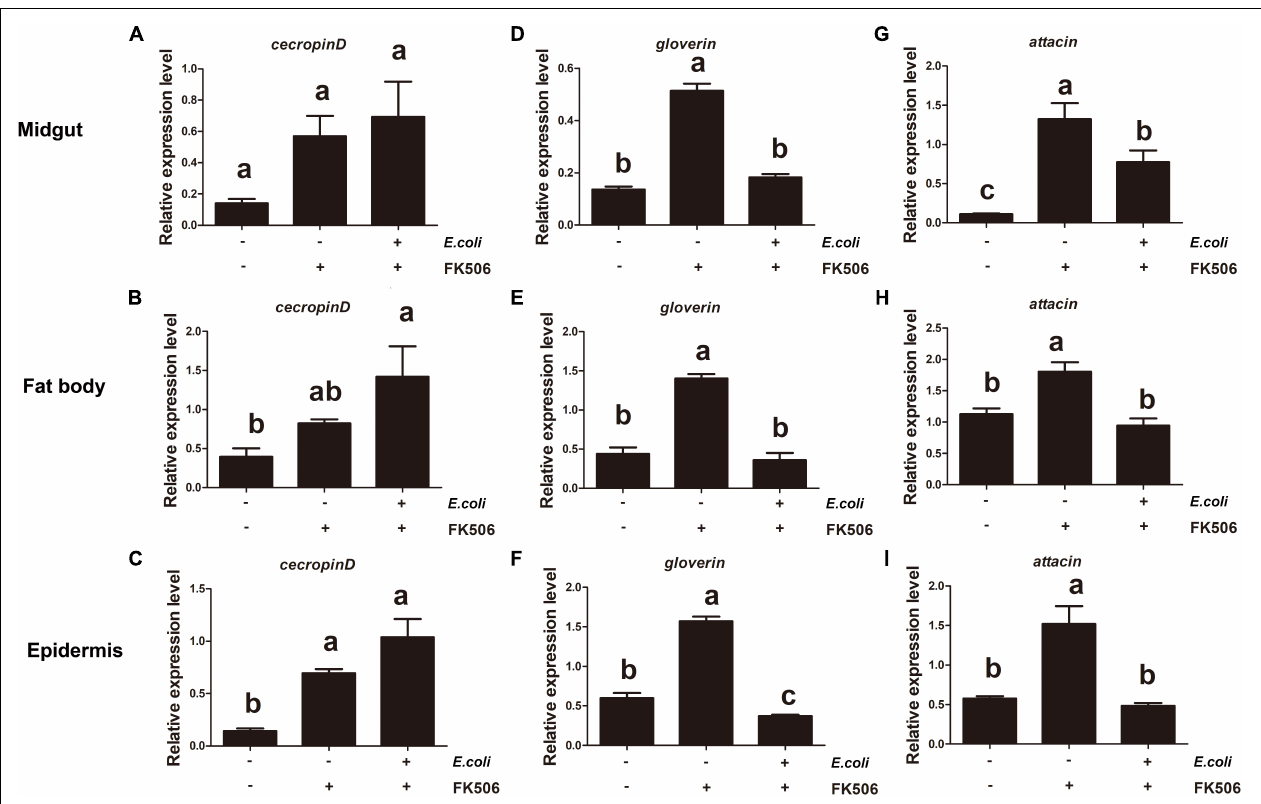
FIGURE 6 | Expression levels of endogenous antimicrobial peptides (cecropin D, attacin, and gloverin) in the midgut, fat body, and epidermis in response to Escherichia coli infection and E. coli + FK506 in fourth instar H. armigera after 3 h treatment. (A–C) Represent the relative expression levels of cecropin D in the migut, fat body, and epidermis, respectively. (D–F) Represent the relative expression levels of attacin in the migut, fat body, and epidermis, respectively. (G–I) Represent the relative expression levels of gloverin in the migut, fat body, and epidermis, respectively. Values shown are means and standard errors. Statistically significant differences for experimental comparisons are indicated by different small letters [analysis of variance (ANOVA) and Tukey’s test, P < 0.05;